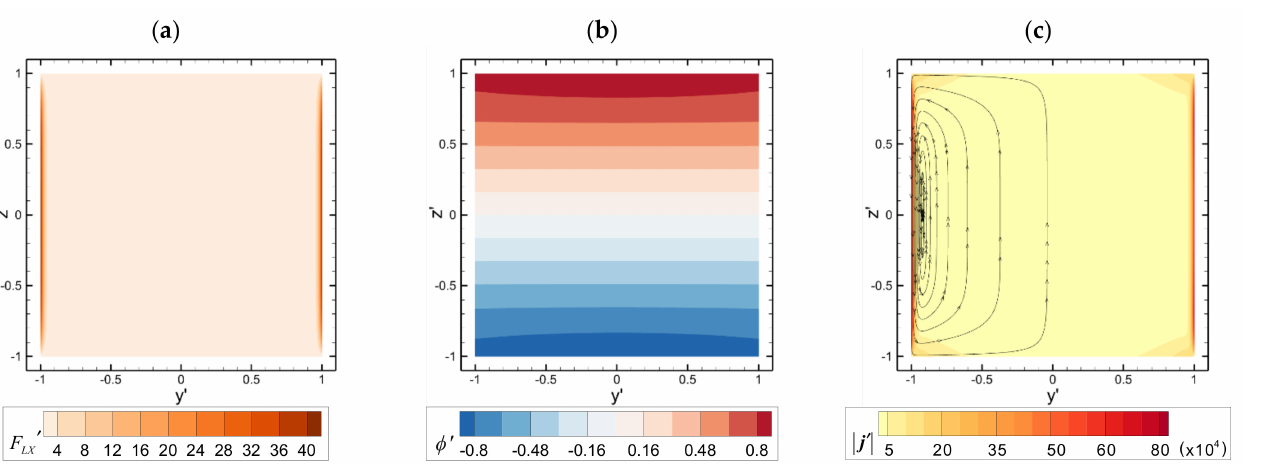
(cid:12) (cid:12) ’ (cid:12) (cid:12) (cid:12) j (cid:12) , and the electric current vector j